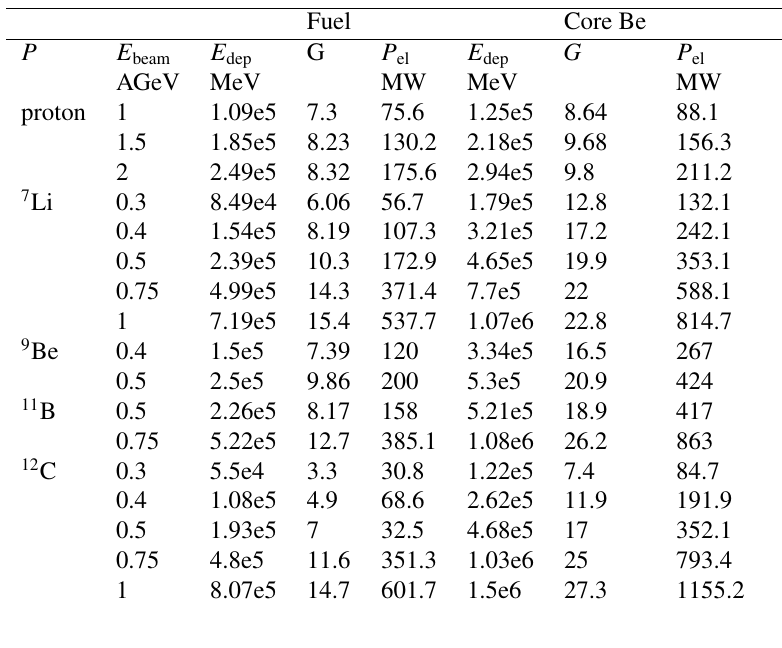
Table 1. The energy released E dep , the gain factor G and the net electrical power P el produced in enriched U target irradiated with protons and light